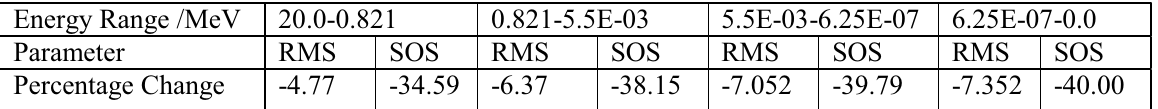
Table III.: Percentage Change of Root Mean Squared and Standard Deviation of Standard